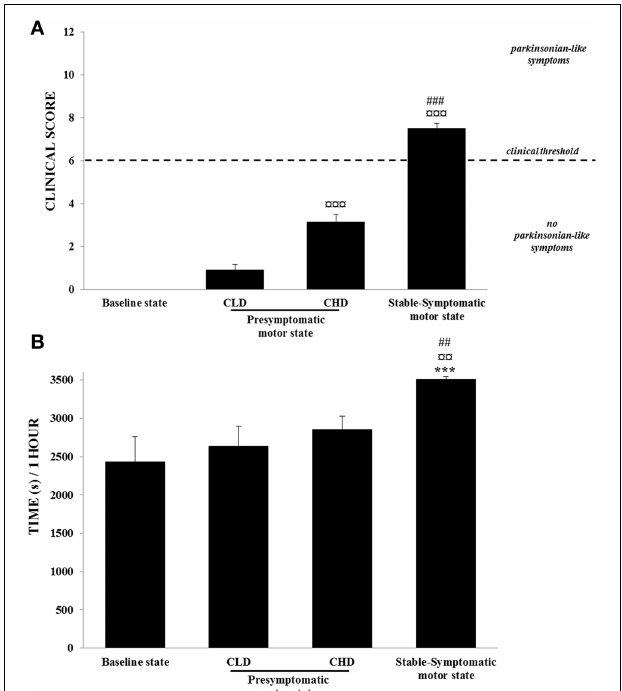
FIGURE 3 | Motor abilities from baseline to presymptomatic and symptomatic motor states ( n = 6). (A) Clinical score: values were means ± SD ( n = 6). ¤¤¤ p < 0 . 001: CHD-presymptomatic and stable-symptomatic motor states vs. CLD-presymptomatic motor state; ### p < 0 . 001: stable-symptomatic motor state vs. CHD-presymptomatic motor state (Student t -test). (B) Time spent in inactivity: values